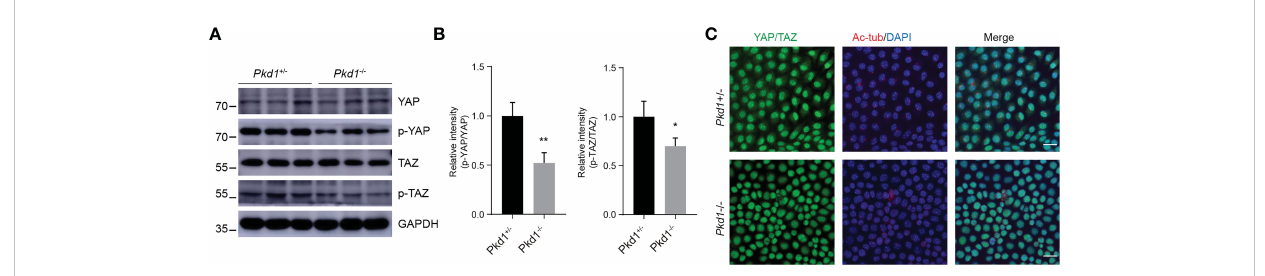
FIGURE 3 Increased nuclear accumulation of YAP/TAZ in the absence of PC1. (A) Representative western blotting images of YAP, phospho-YAP, TAZ and phospho-TAZ in ciliated Pkd1 +/- and Pkd1 -/- cells. (B) Relative intensities of phospho-Yap to Yap and phospho-TAZ to TAZ. Error bars indicates standard deviation of three independent experiments (* P < 0.05, ** P < 0.01; Student ’ s t test). (C) Immuno fl uorescence staining of YAP/TAZ (green), acetylated a -tubulin (red), and DAPI (blue). Scale bar: 25 m m.